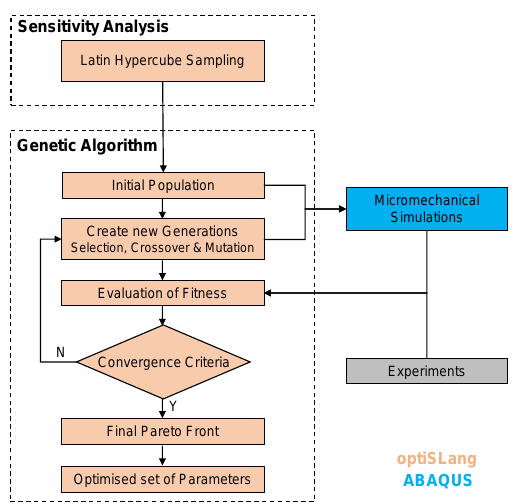
Figure 10. Flow chart of the calibration procedure for the crystal plasticity parameters using a genetic